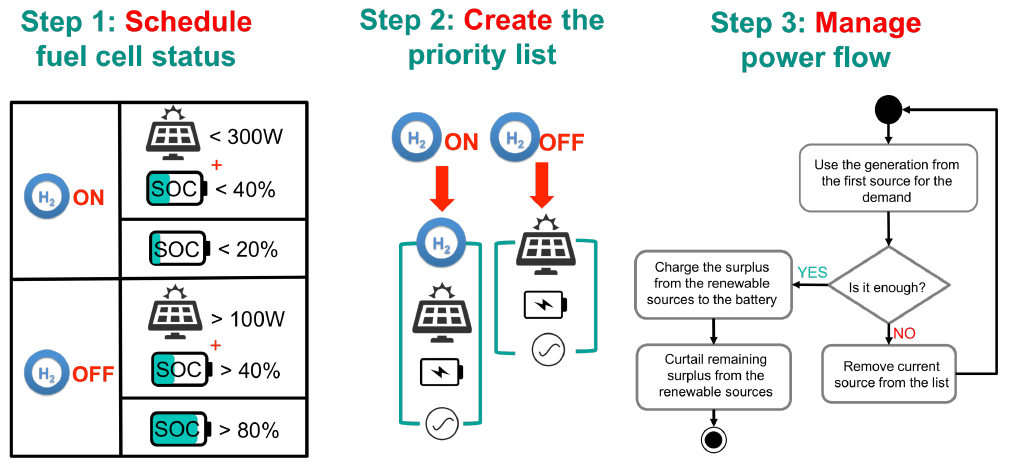
Figure 2. Scheduling conditions and simplified workflow of the internal agent.